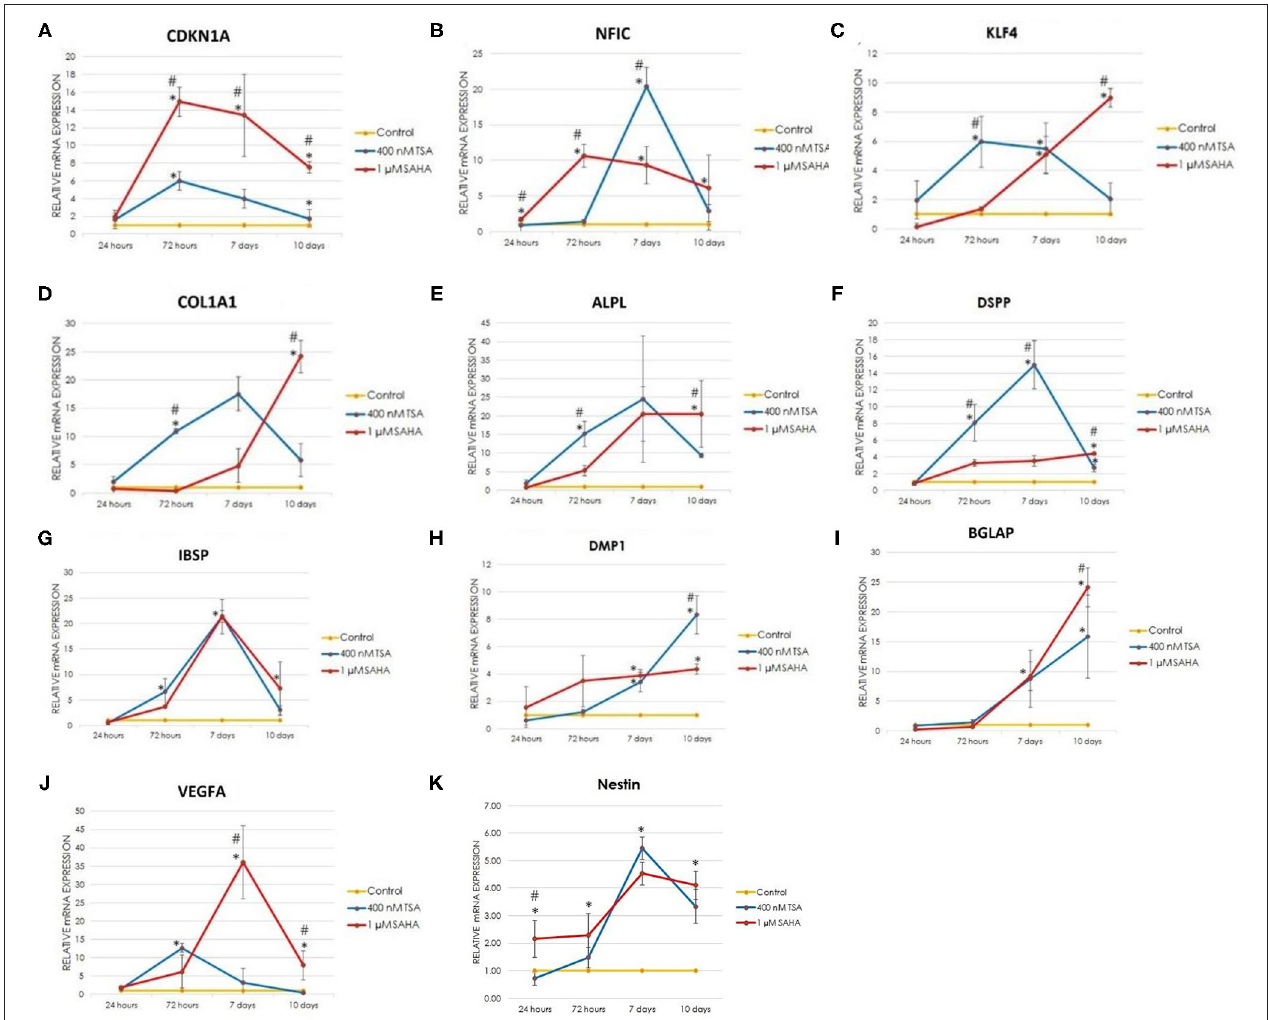
FIGURE 4 | The relative expression of odontoblast-related genes during odontogenesis was determined by Real Time RT-PCR at 24, 72h, 7, and 10 d post-induction. (A) CDKN1A : cyclin dependent kinase inhibitor 1A, (B) NFIC : nuclear factor I C, (C) KLF4 : kruppel like factor 4, (D) COL1A1 : collagen type I alpha 1 chain, (E) ALPL : alkaline phosphatase, (F) DSPP : dentin sialophosphoprotein, (G) IBSP : integrin binding sialoprotein, (H) DMP1 : dentin matrix acidic phosphoprotein 1, (I) BGLAP : bone gamma-carboxyglutamate protein, and (J) VEGF : vascular endothelial growth factor A, (K) Nestin (one-way ANOVA, Tukey’s HSD post hoc test, Asterisks indicate a significant difference compared with control at p < 0.05, Hashtags indicate a significant difference between the TSA- and SAHA-treated groups at p < 0.05, n =